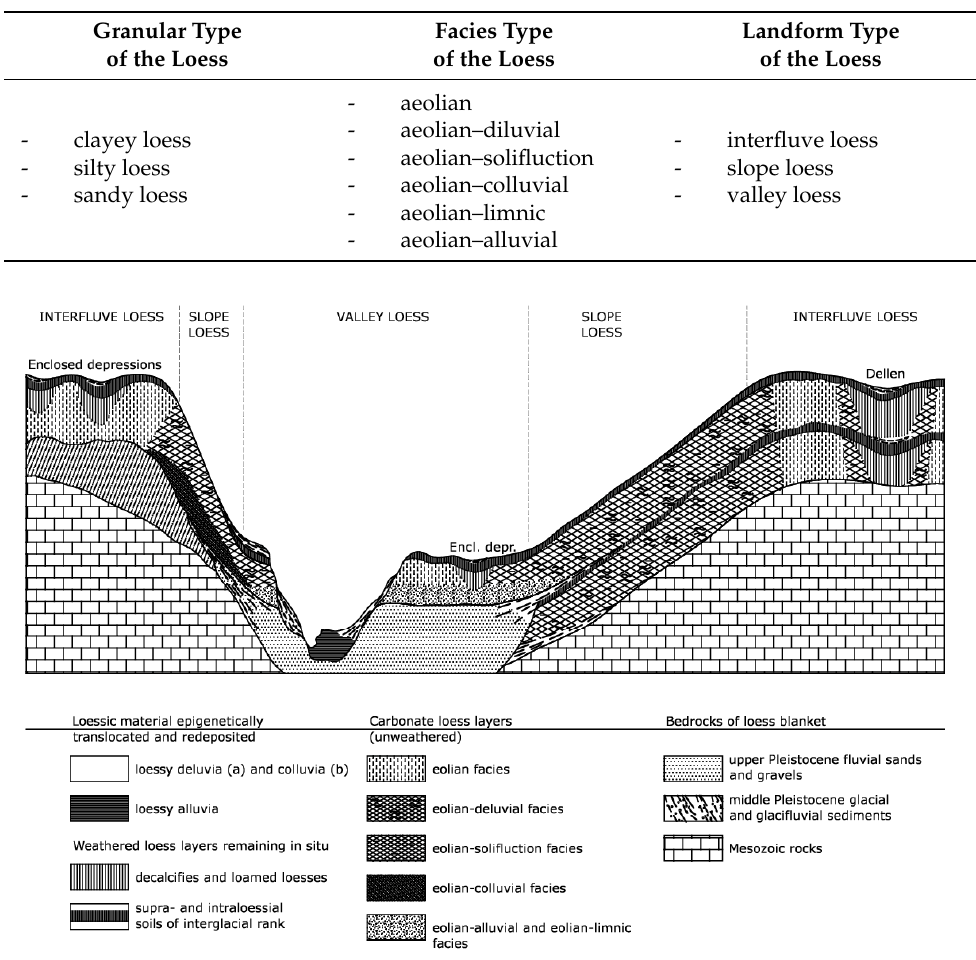
Table 1. Division of loess according to Maruszczak [2].